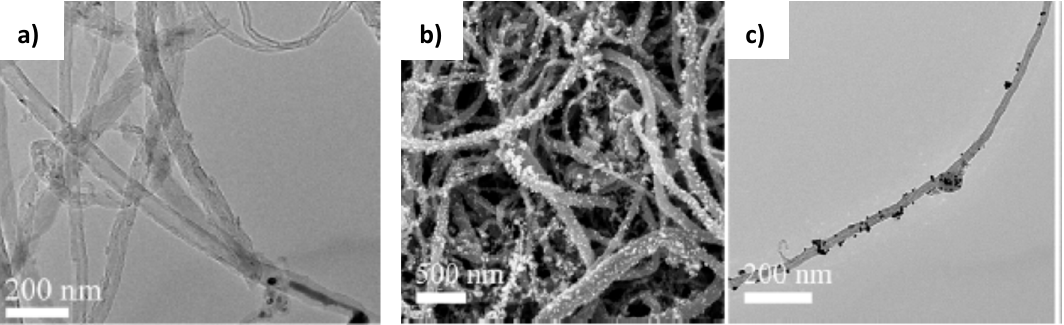
Figure 17. TEM of pristine CNT ( a ), SEM of HCNM-supported AuNPs ( b ), TEM of AuNPs-decorated CNT ( c ). (Reprinted from [61]).